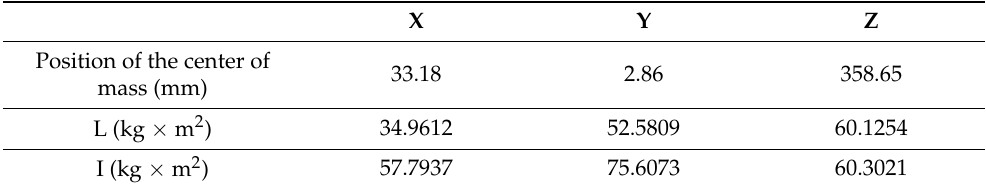
Table 1. The roller shutter gripper parameters.